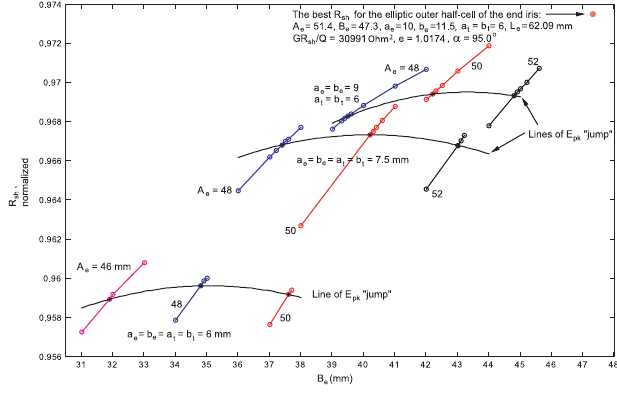
FIG. 16. (Color) Normalized R sh for the type b end cells.